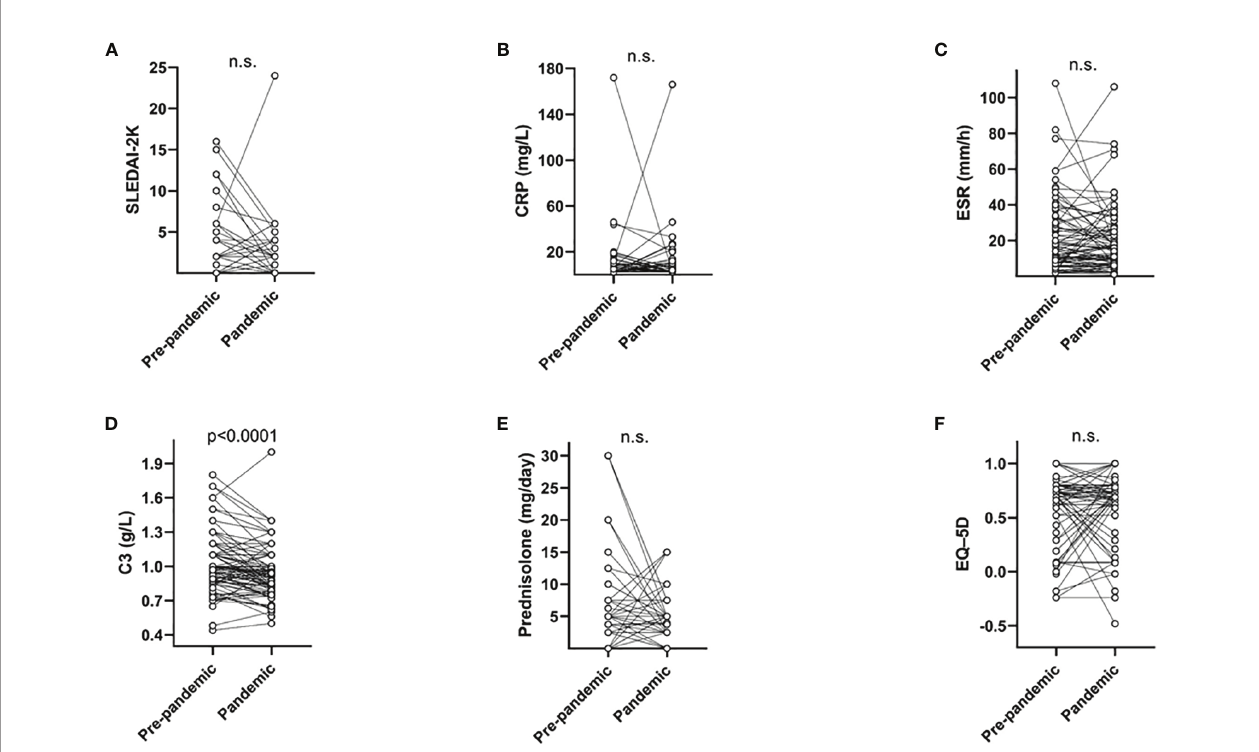
FIGURE 2 | Global SLE disease activity (SLEDAI-2K) (A) , C-reactive protein (CRP) (B) , erythrocyte sedimentation rate (ESR) (C) , Complement protein 3 (C3) (D) , daily prednisolone dose (E) , and EuroQoL-5 dimensions (EQ – 5D) (F) shown for the 100 included patients with SLE before and during the pandemic. Only the C3 levels were signi fi cantly lower during the pandemic compared with prepandemic samples. n.s., not signi fi cant.